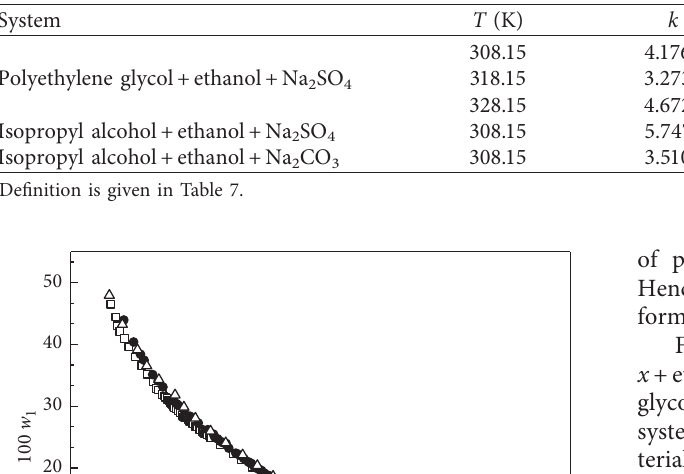
Table 8: Parameters of equation (9) for the mixture of polyethylene glycol/isopropyl alcohol +ethanol +salt (Na ATPSs at different temperatures.